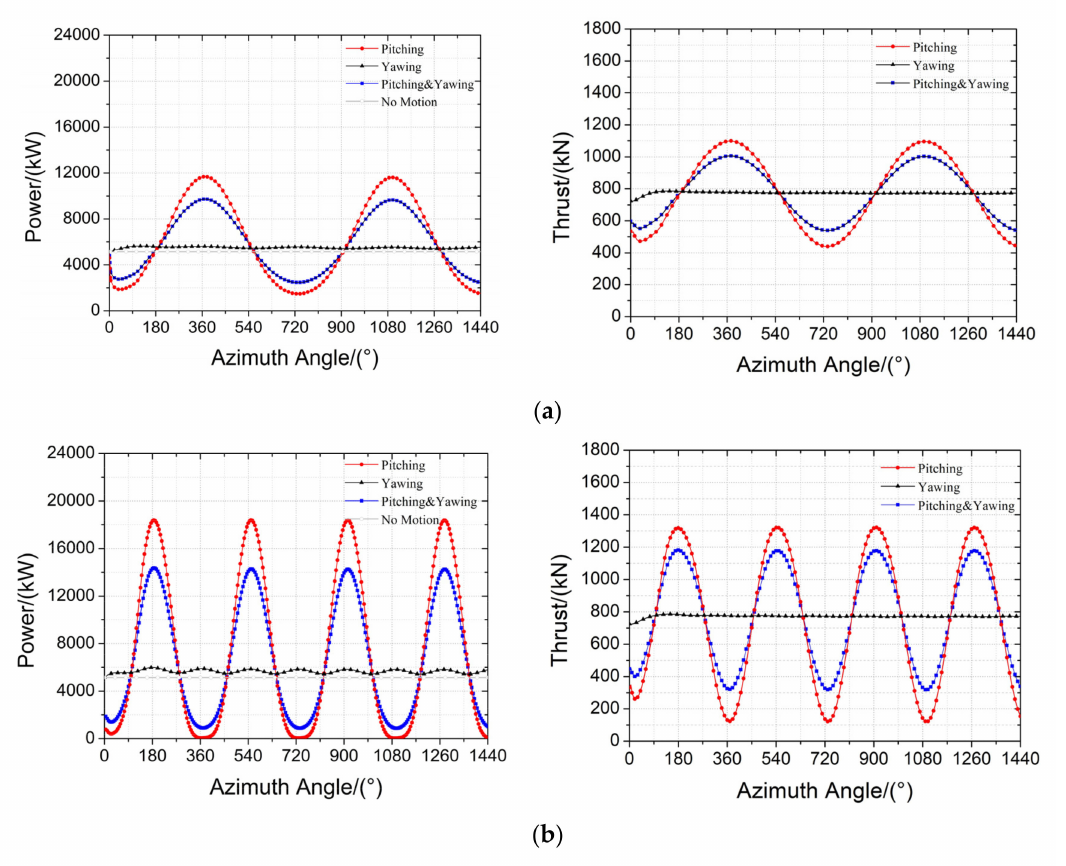
Figure 8. Variation in total performance. ( a ) f = 0.1 Hz; ( b ) f = 0.2